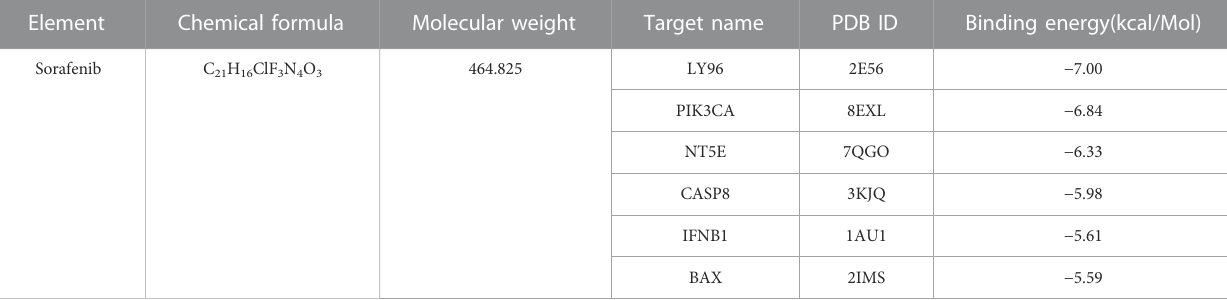
TABLE 2 Basic information on the molecular docking between sorafenib and the target protein.